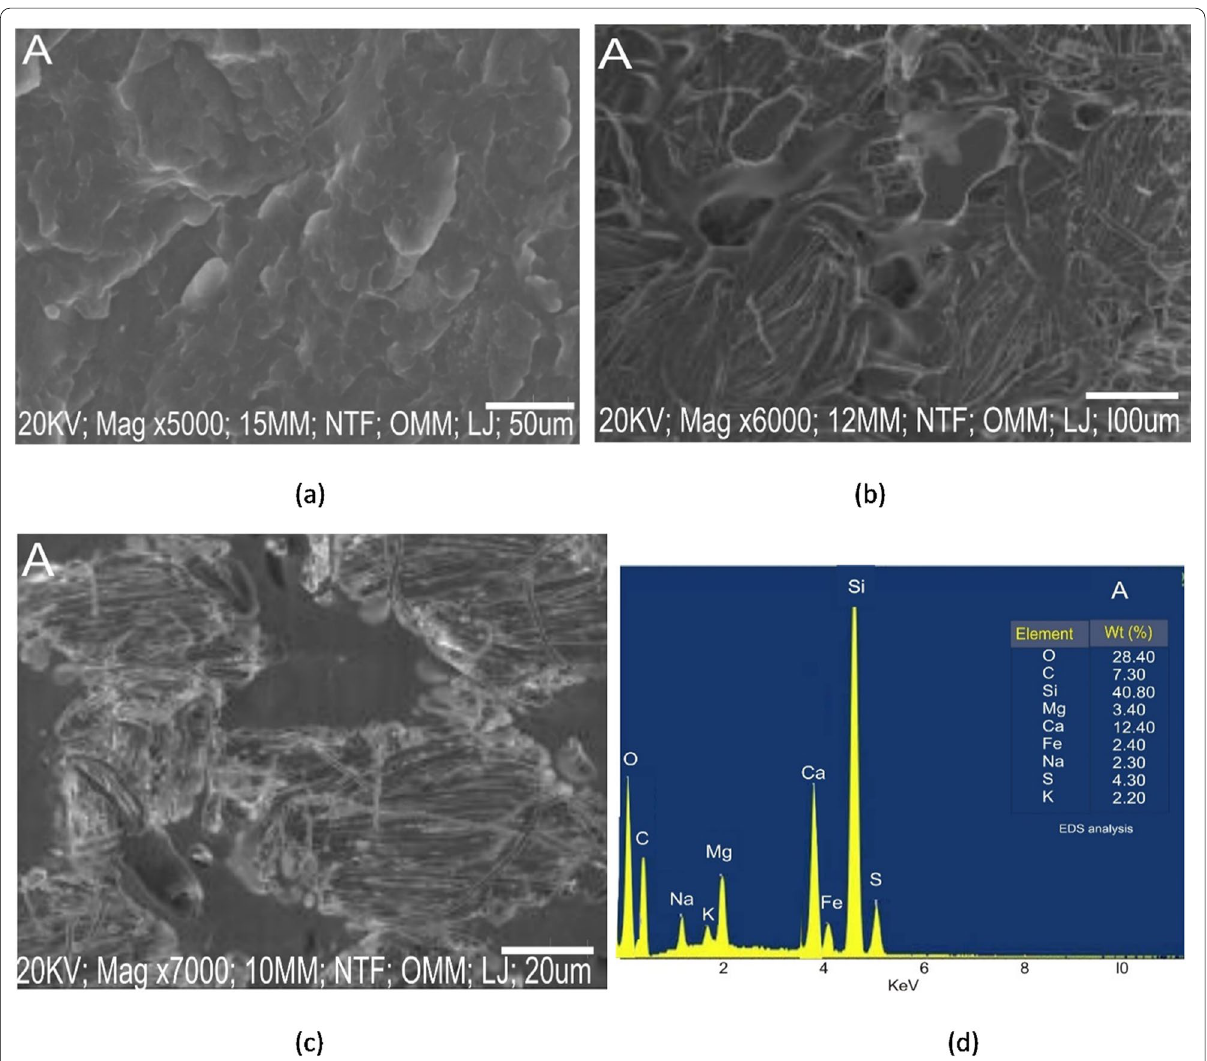
Fig. 3 SEM micrographs of the nanocomposite film at different magnification ratios a 500, b 600, c 7000, d EDS analysis showing constituent